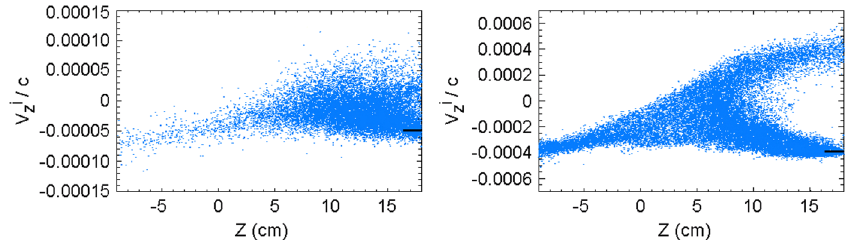
g plasma ion phase space plots for the cases of initial v i FIG. 20. (Color) f z; v z Counterpropagating ion streams (due to mirroring) are evident for z > 2 cm . Horizontal black bars demarcate the injected initial v i both